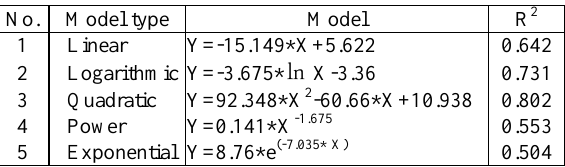
Table 1. The regression models for soil moisture retrieval